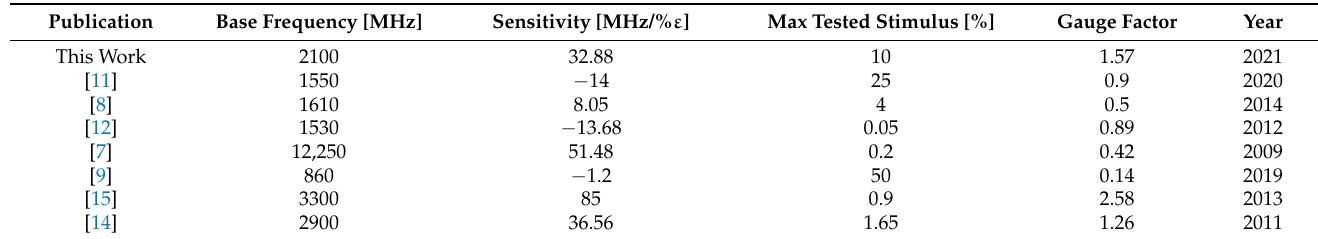
Table 7. FEA sensor specifications.